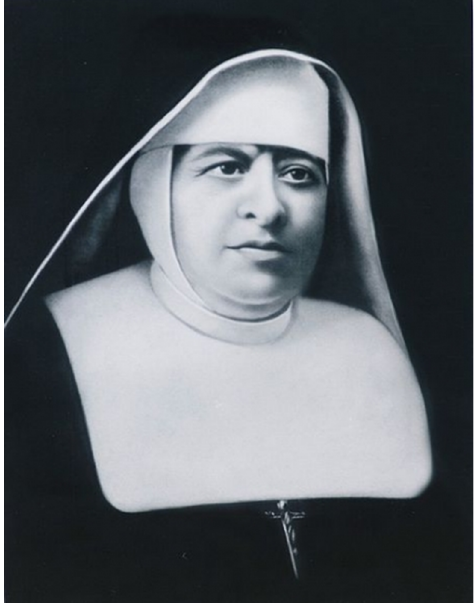
Figure 1. Reproduced photograph of Sister Marija Krucifiksa Kozulić (1852–1922) [1].